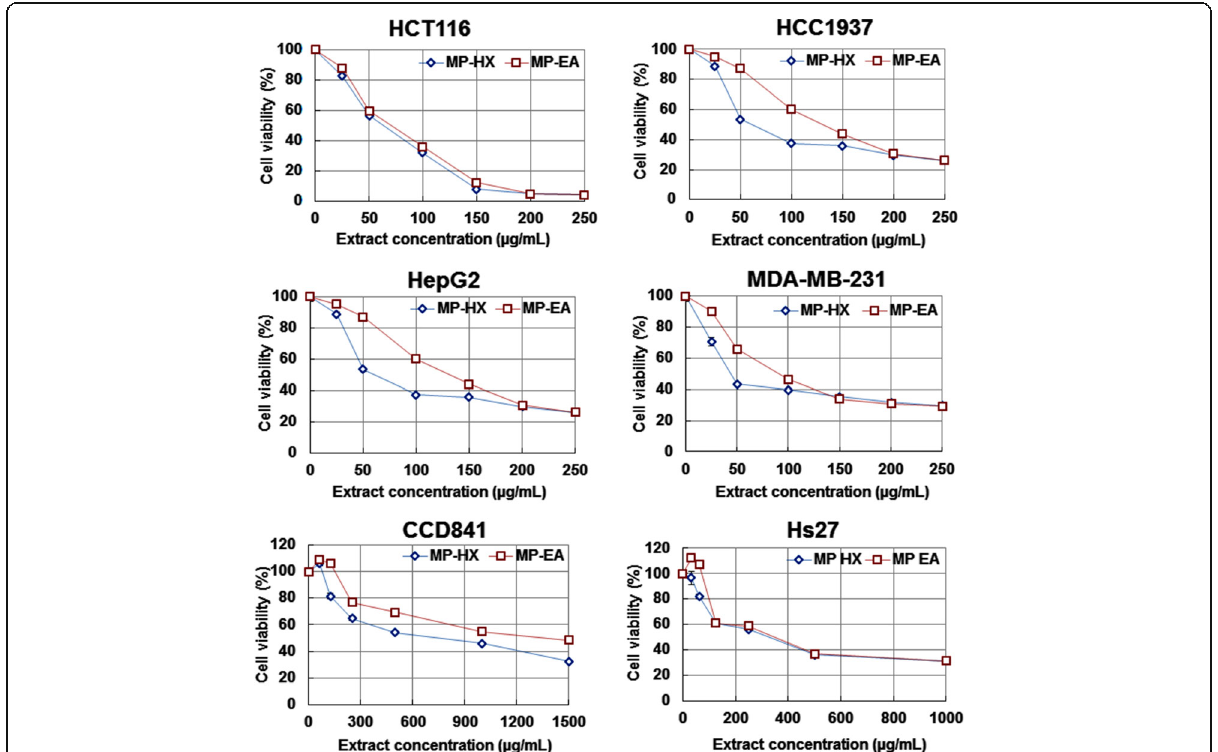
Fig. 4 MTS cell viability assay. Dose response curves for the cytotoxic effect of MP-HX and MP-EA (48 h treatment) on cancerous (HCT116, HCC1937, HepG2, MDA-MB-231) and non-cancerous (CCD841, Hs27) cell lines